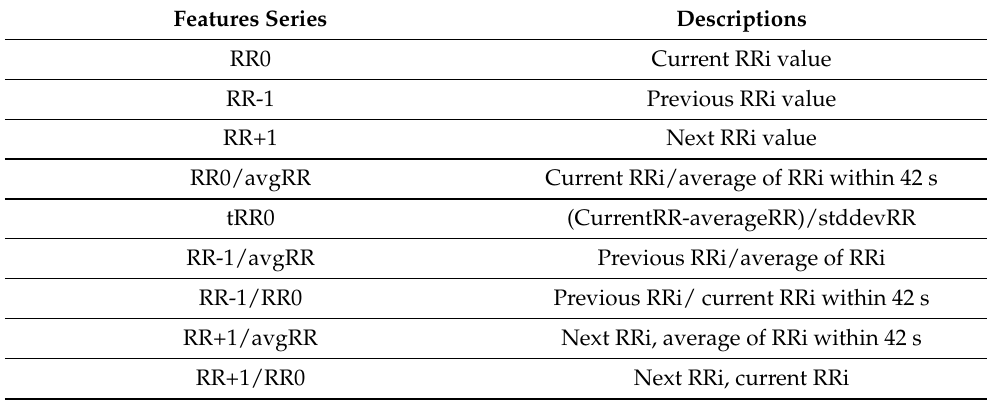
Table 2. RR interval feature